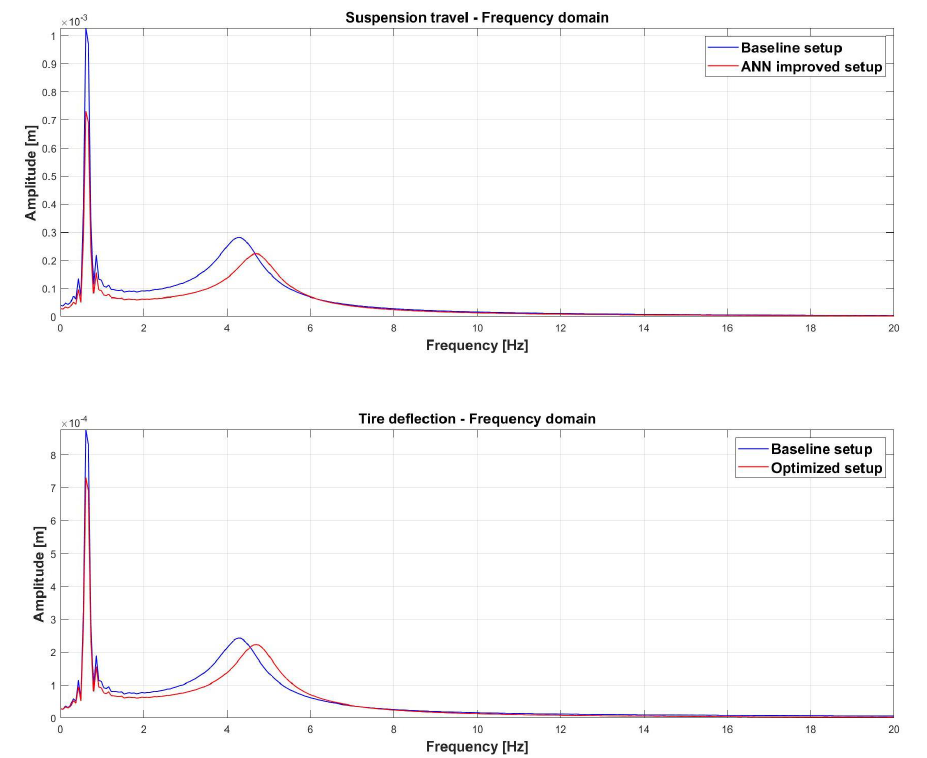
Figure 18. Comparison between the baseline setup and optimized setup. The optimized setup is able to reduce the resonance peak amplitude of suspension travel and tire deflection in the frequency domain.